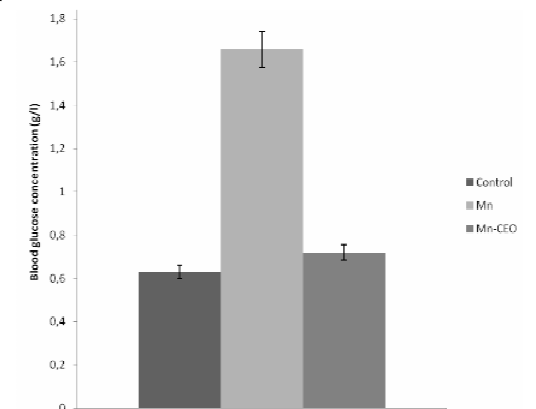
Fig. 3. Blood glucose level (g/l) of control (C) and manganese exposed during gestation lactation (Mn) and treated rats by clove essential oil (Mn-CEO).Data are mean ± S.E.M. * p <0.05. (Mn vs. Control) p <0.05